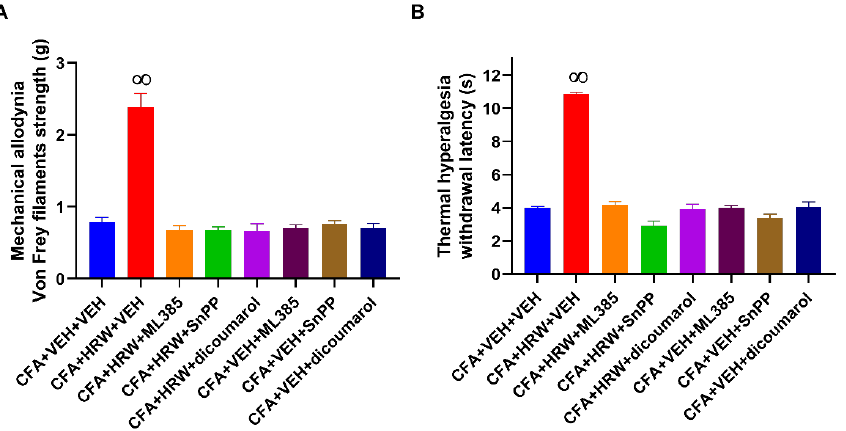
Figure 6. Reversion of the local analgesic actions of HRW produced by the Nrf2/HO-1-NQO1 signaling inhibitors during inflammatory pain. Effects of the subplantar co-administration of HRW with specific inhibitors of Nrf2 (ML-385, 650 µ g), HO-1 (SnPP, 250 µ g), and NQO1 (dicoumarol, 250 µg) or VEH on the mechanical allodynia ( A ) and thermal hyperalgesia ( B ) caused by CFA in the ipsilateral paws of mice are shown. For each test, ∞ denotes significant differences vs. other groups ( p < 0.05; one-way ANOVA and Student–Newman–Keuls test). Data are presented as mean values ± SEM; n = 6 animals for group.